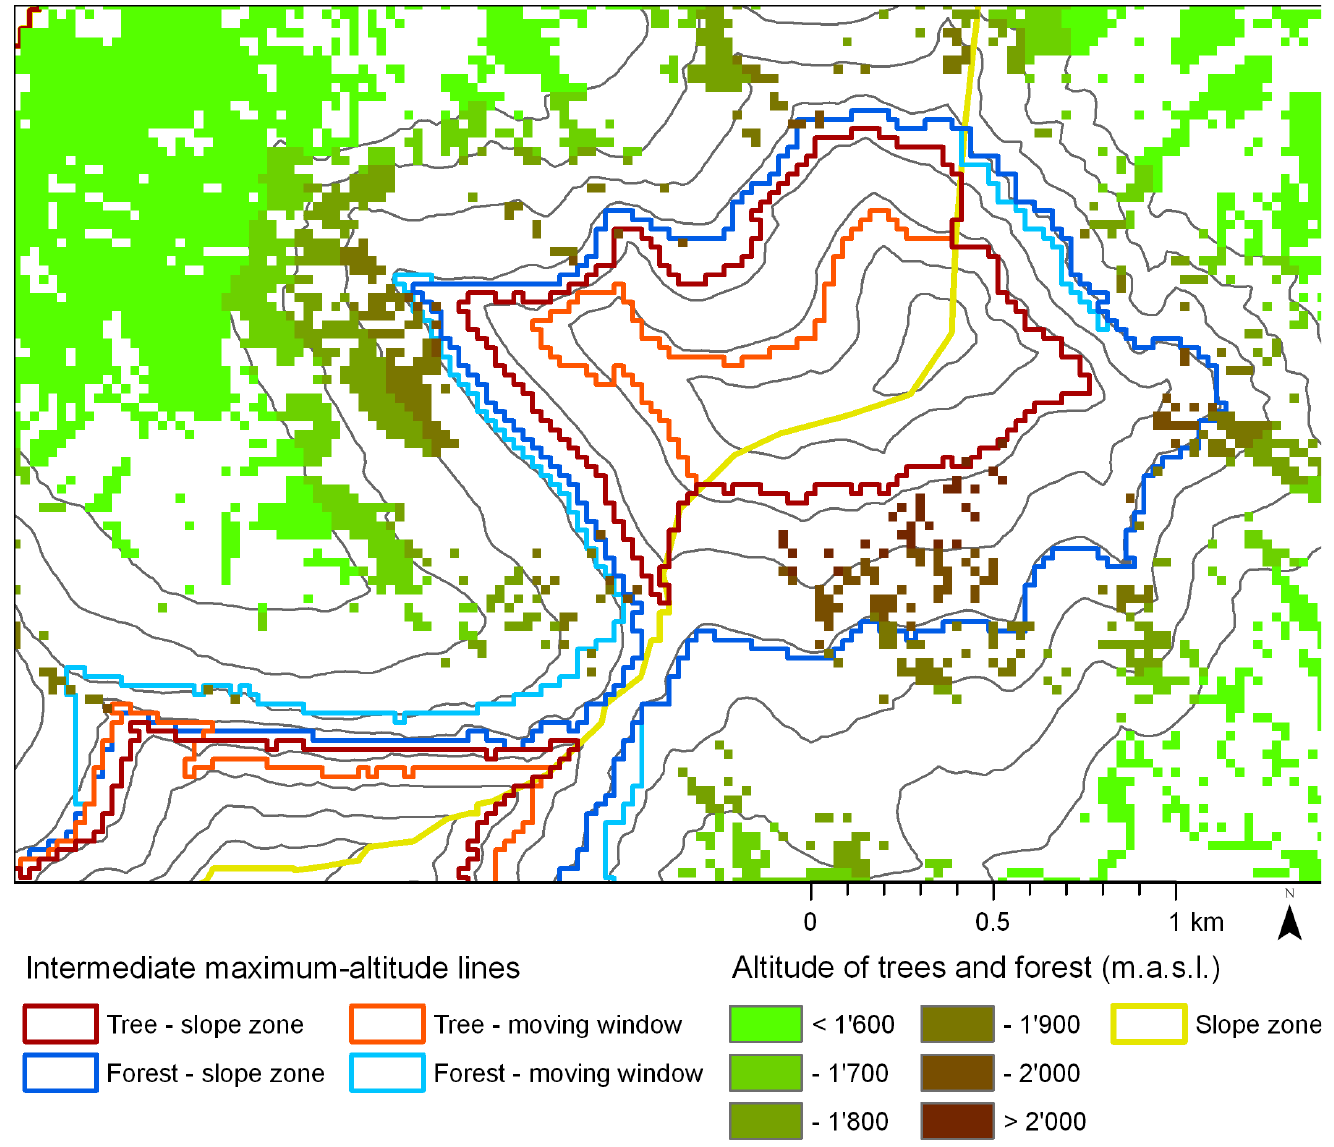
Figure 5. The dark red line indicates the maximum altitude of a tree inside the respective slope zone. The dark blue line shows the same for closed forest. The orange line is the result of the moving-window analysis recording the maximum altitude of a tree in a search radius of 1 km. The light blue line is the result of the moving-window analysis on closed